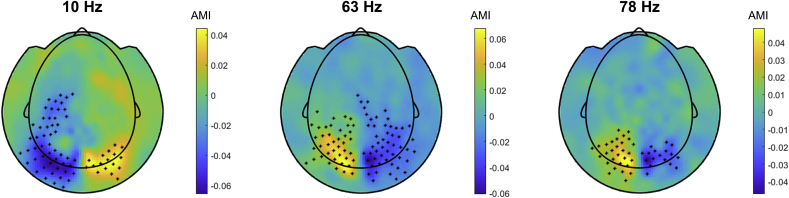
Group average topography maps of the AMI in the alpha band (10 ± 2 Hz) and tagging frequencies (63 and 78 Hz). Black dots indicate MEG sensors at which amplitude modulation index was significantly different from zero (p < 0.05, cluster-based permutation).